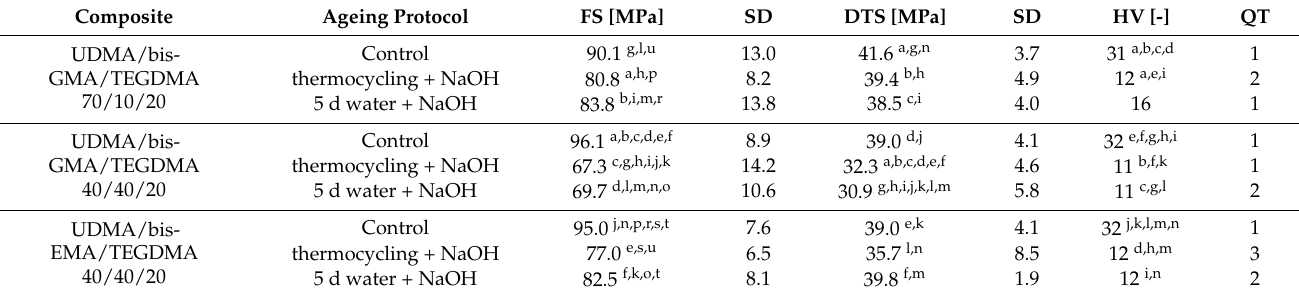
Table 4. The flexural strength (FS), diametral tensile strength (DTS) and hardness (HV) of the tested composites after selected ageing protocols. Normally-distributed variables are given as means with standard deviation, while non-normally distributed variables are given as median with quartile deviation. The results with the same assigned letter show a significant difference at the level of p ≤